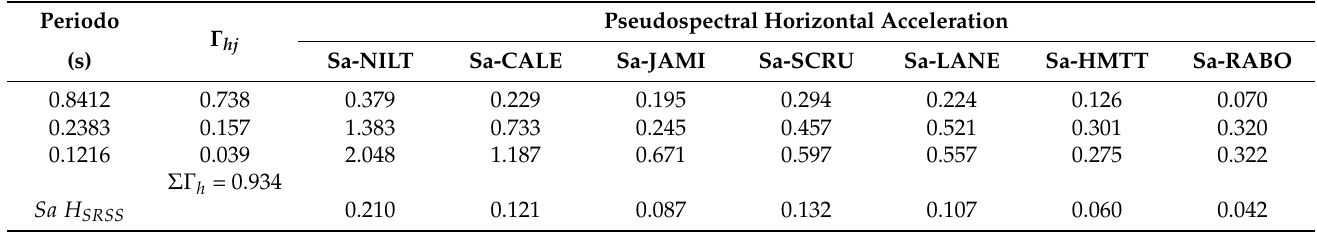
Table 7. Accelerations due to horizontal earthquake in the 10-story building.